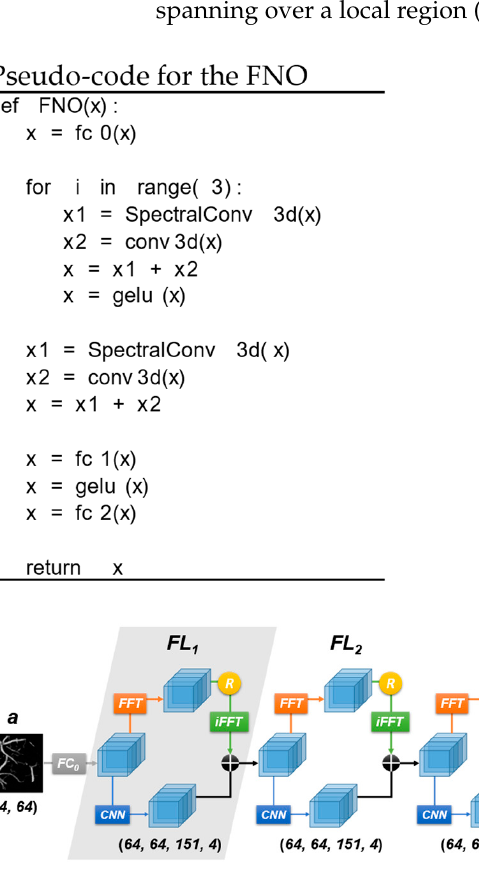
Figure 2. Neural network architecture for the FNO network. The input a (initial pressure distribution a) is mapped to a higher dimensional space using a fully connected layer (FC 0 ). The transformed feature is passed through four Fourier Layers (FLs). Finally, a fully connected layer (FC 2 ) is used to obtain the final output u (solution to the wave equation u) with the desired dimensions. The input goes through two paths in each Fourier layer. In the top path, the input undergoes a Fourier Transform FFT, linear transform R and inverse Fourier Transform iFFT. In the bottom path, the input undergoes a linear transform. Outputs from each path are summed together and undergo GeLU activation. The dimension of the feature representation for each operation is given in the